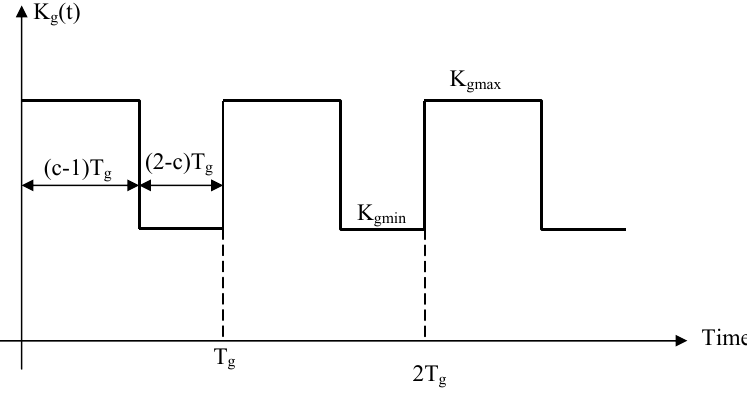
Fig. 3. Time varying evolution of K g ( t ) for a constant rotational speed n r 1